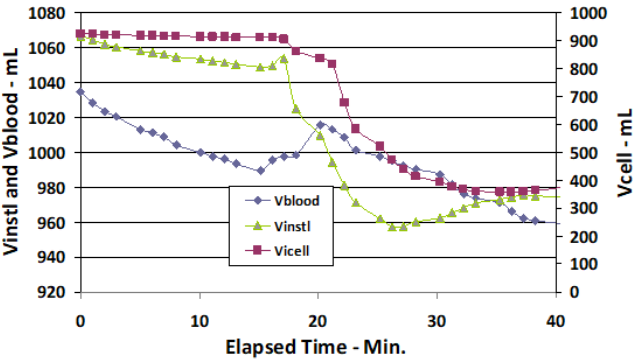
Figure 4. Vblood, Vinst) and Vcell volumes (mL) of the calf during start of DTM vs. Elapsed Time (min).